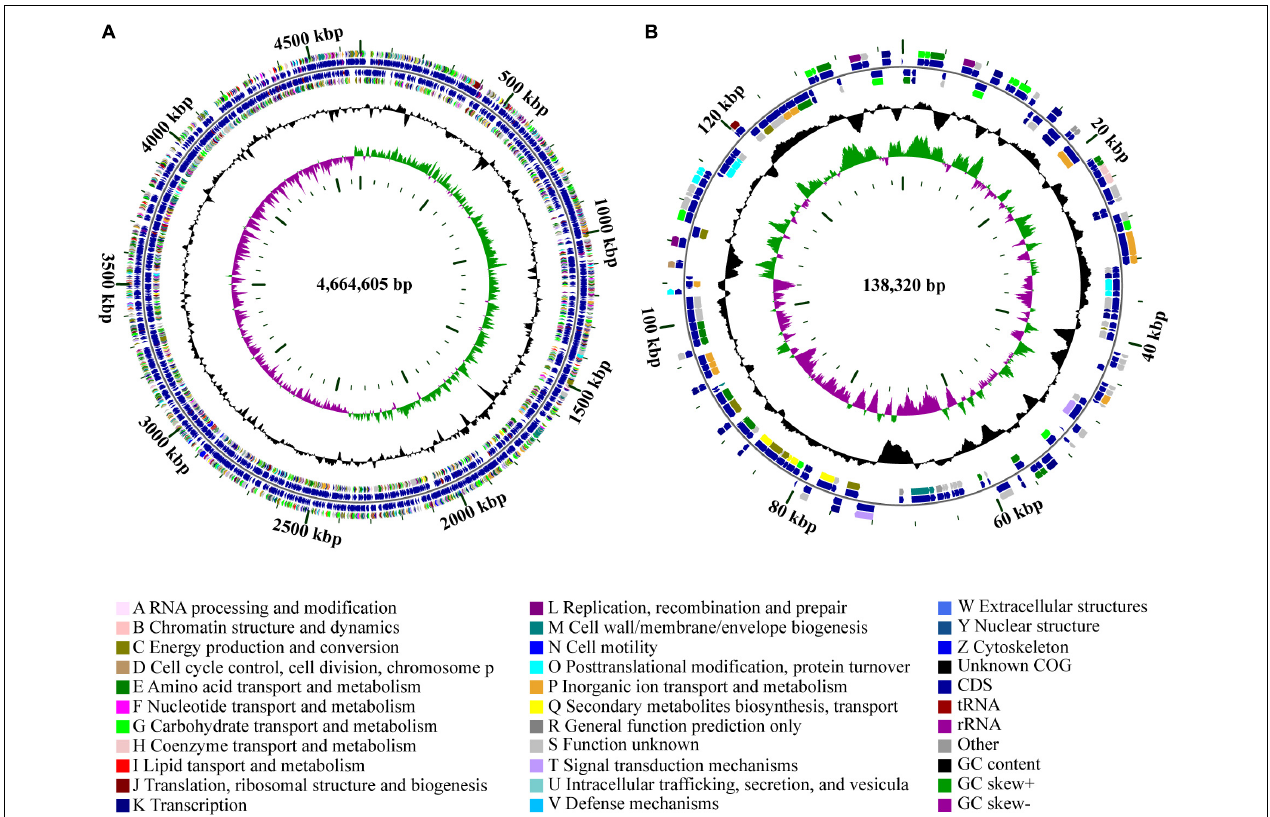
FIGURE 1 | Circular genome maps of (A) chromosome and (B) plasmid of strain Cp2. The circles from the inside to outside represent: (1) GC skew; (2) GC content; (3) CDS on the reverse strand was annotated by COG database; (4) CDS, rRNA, and tRNA on the reverse; (5) CDS, rRNA, and tRNA on the forward; (6) CDS on the forward; (7) scale of genome